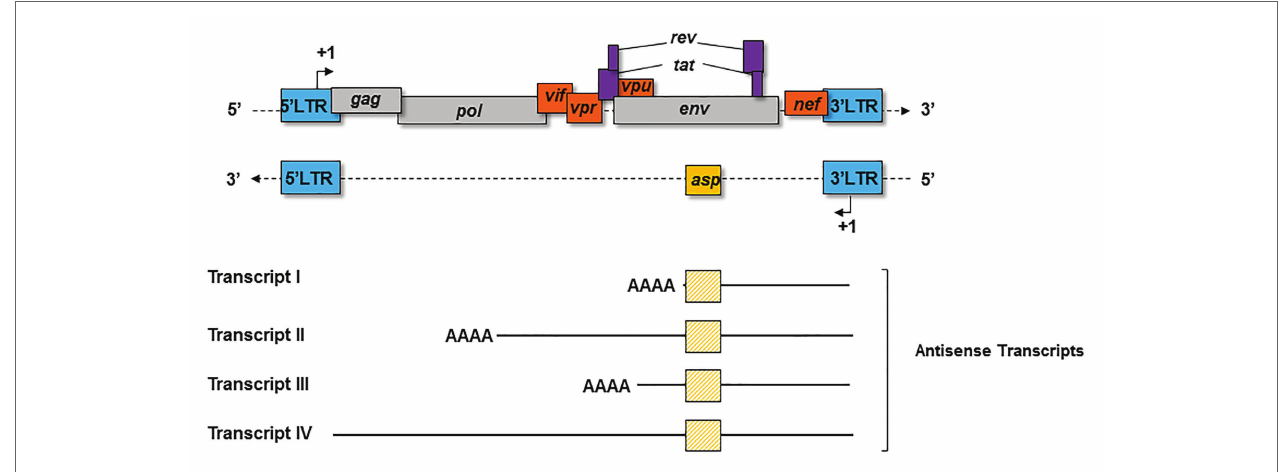
FIGURE 3 | Schematic representation of the principal antisense transcripts that were described in vitro (transcripts I to IV). The poly-A tails and the ASP ORF (yellow square) are represented for each